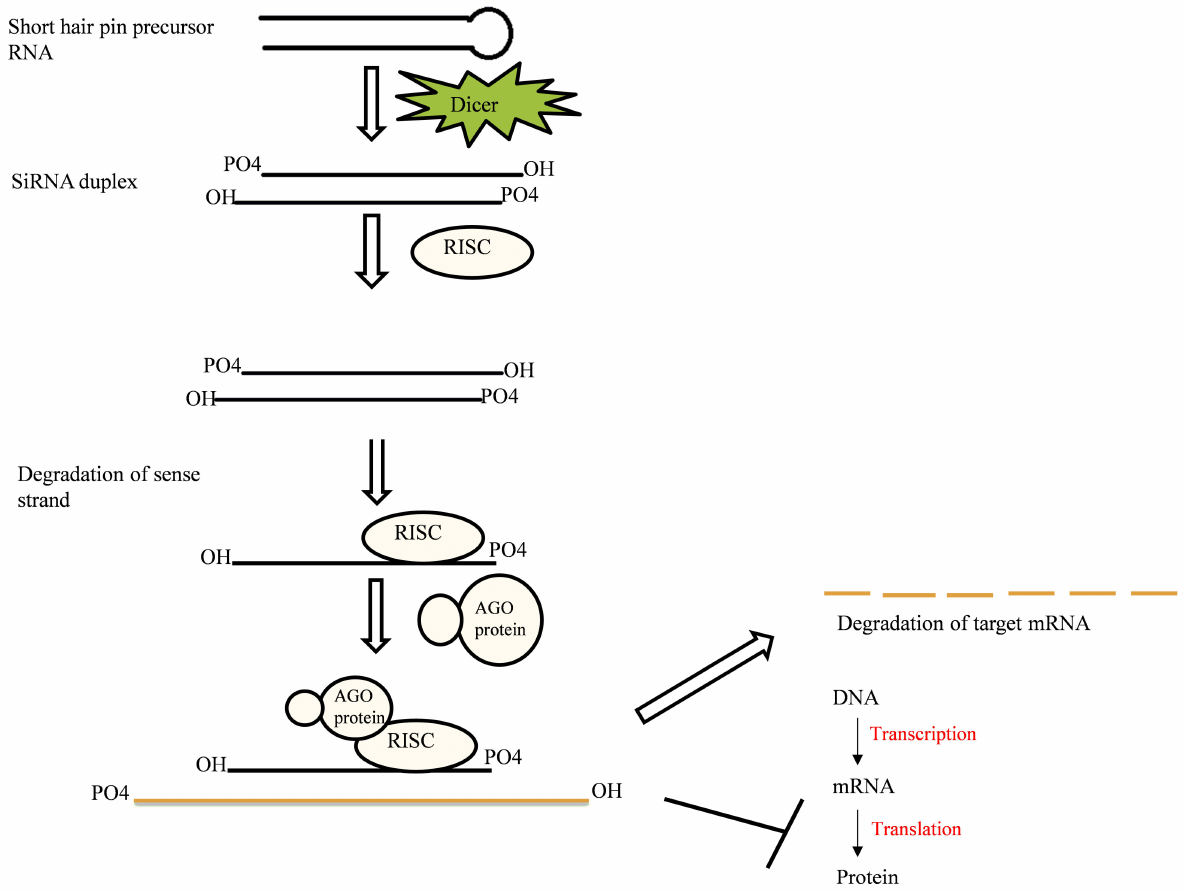
Figure 2. siRNA biogenesis and gene silencing. Here the action of Dicer or the Dicer-like enzyme on the precursor RNA results in an siRNA duplex with overhangs at 3 (cid:48) -OH ends. Further, the antisense strand from siRNA induces the silencing complex by associating with the RISC protein. Thereafter, incorporation of AGO and other effector proteins with siRISC facilitate the gene silencing through degradation of the target mRNA or translation